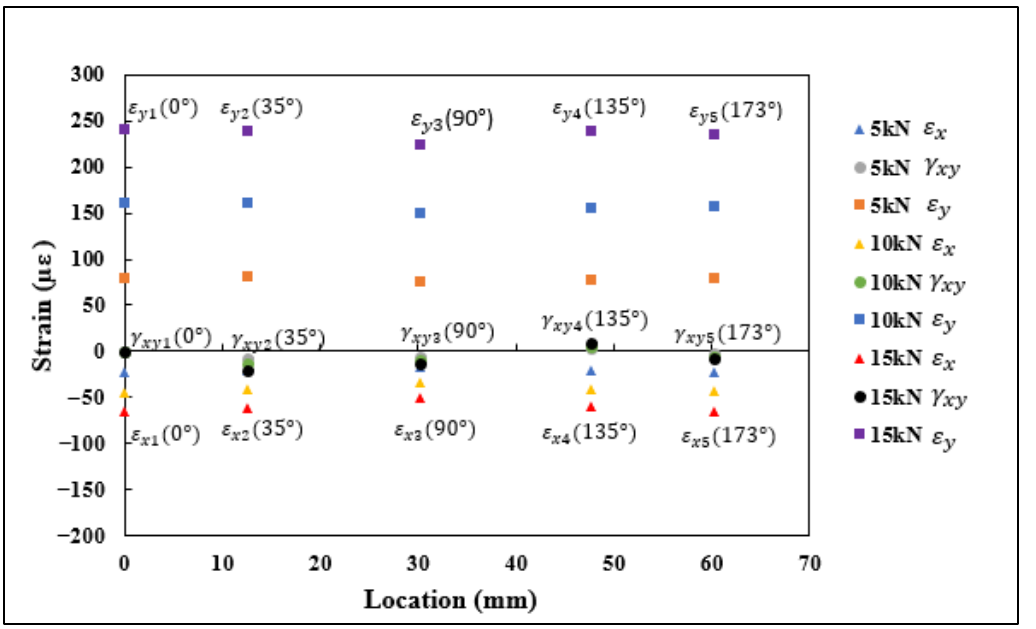
Figure 14. 𝜀 𝑥1 − 𝜀 𝑥5 , 𝜀 𝑦1 − 𝜀 𝑦5 , and 𝛾 𝑥𝑦1 − 𝛾 𝑥𝑦5 strain measurements obtained using strain rosettes. Figure 14. ε